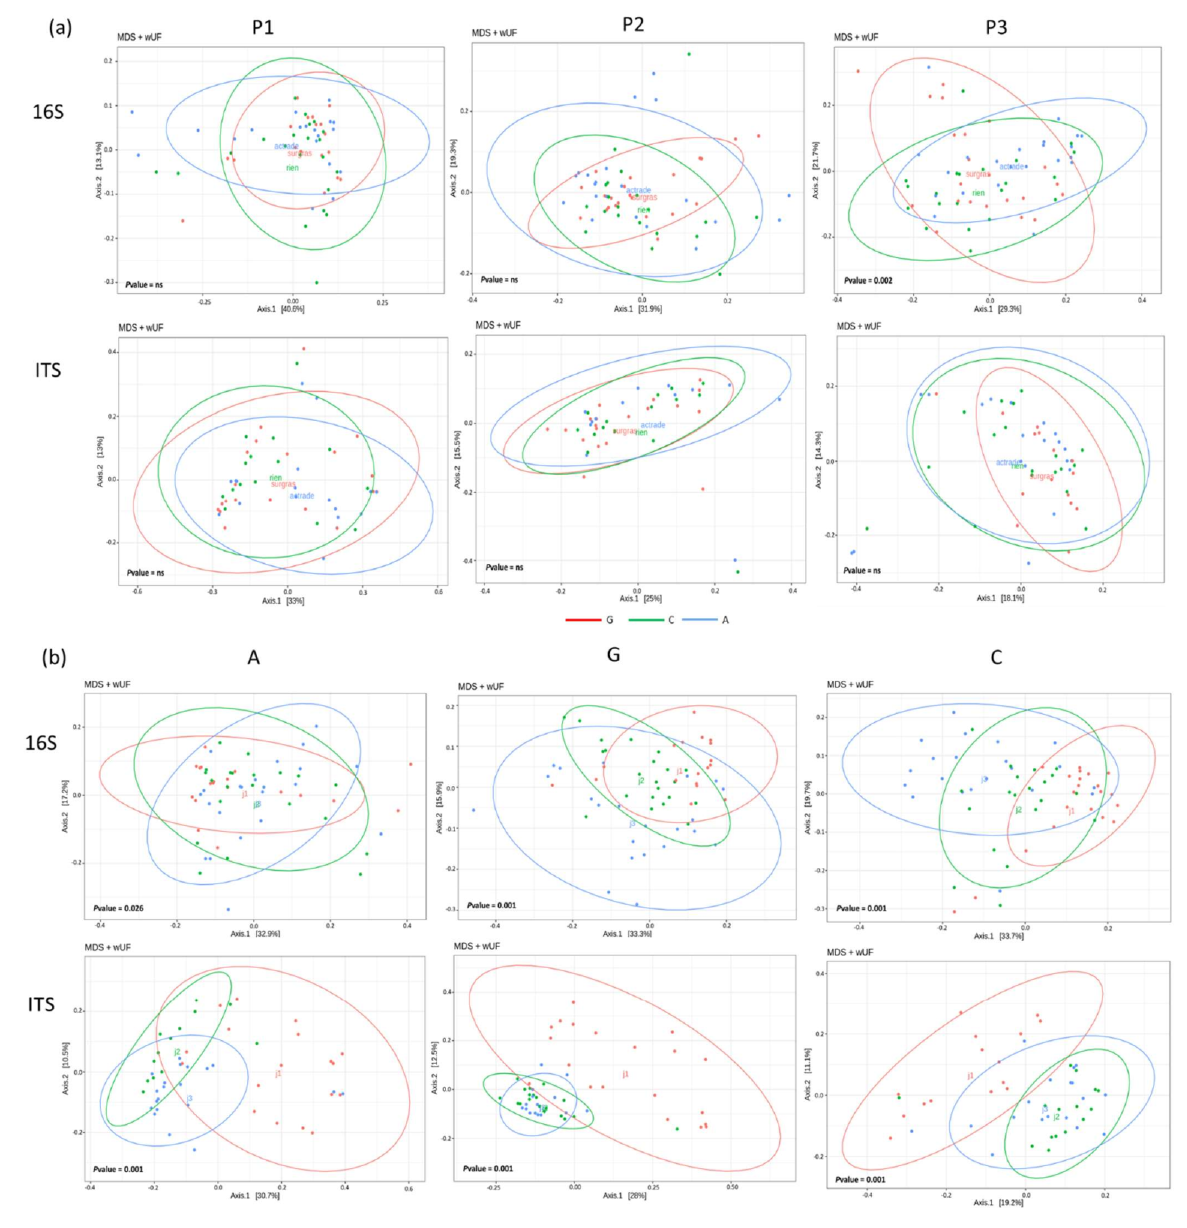
Figure 1. Bacterial (16S) and fungal (ITS) betadiversity of individual teat suspensions according to ( a ) the treatment at each period and ( b ) the period for each